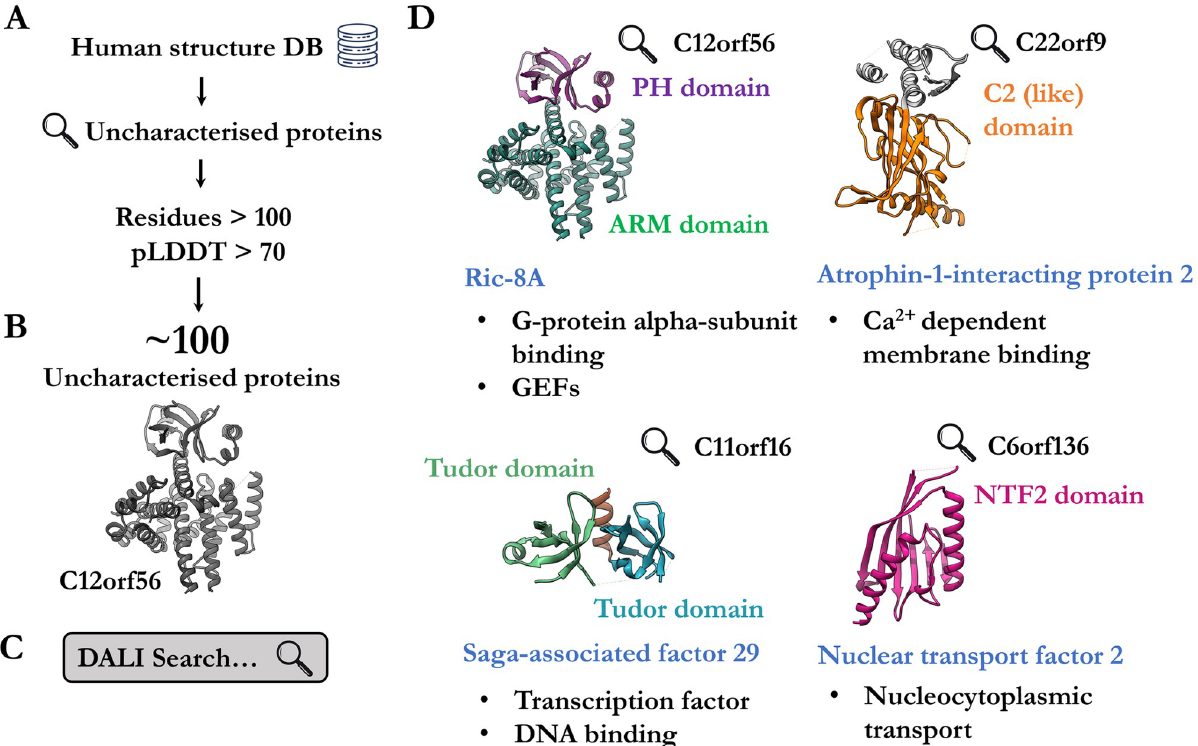
Fig 2. Identification of uncharacterised human proteins by fold-recognition. a . Uncharacterised human proteins were curated from the AlphaFold database. b . Low-confidence regions of AlphaFold models were excluded based on pLDDT criteria. c . All models were screened against the rest of the human AlphaFold database. d . Four examples (C12orf56, Q8IXR9; C22orf9, Q6ICG6; C11orf16, Q9NQ32; C6orf136, Q5SQH8) of uncharacterised proteins where fold-matching enabled the assignment of domain composition (labelled in various colours). Furthermore, homologs or similar proteins (blue label) provide insight into potential function (black dot